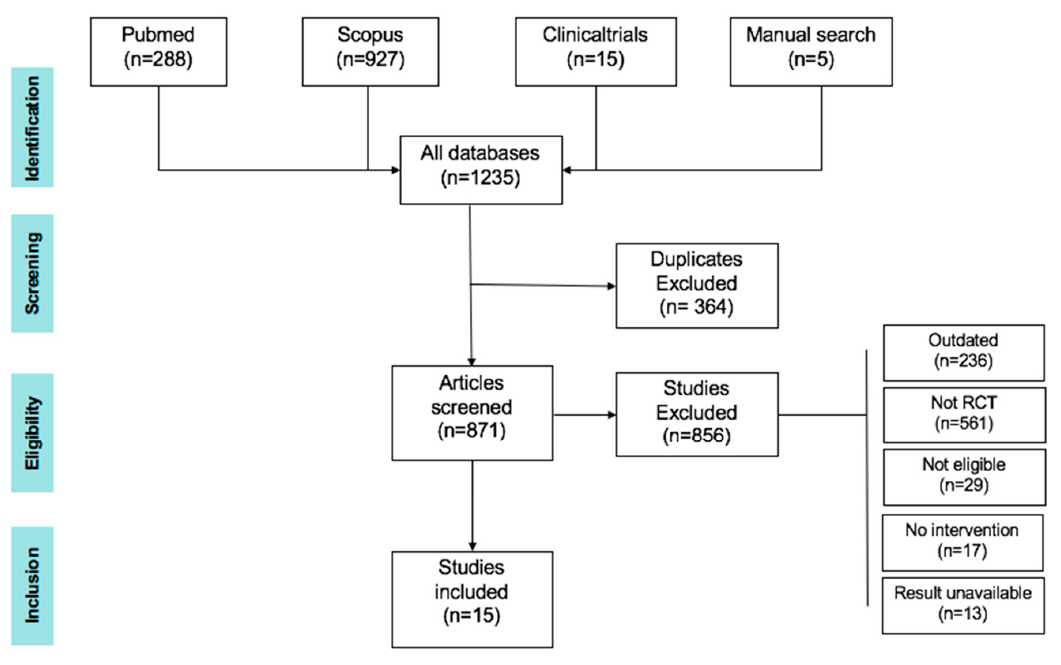
Figure 1. Flowchart of study selection for this review.